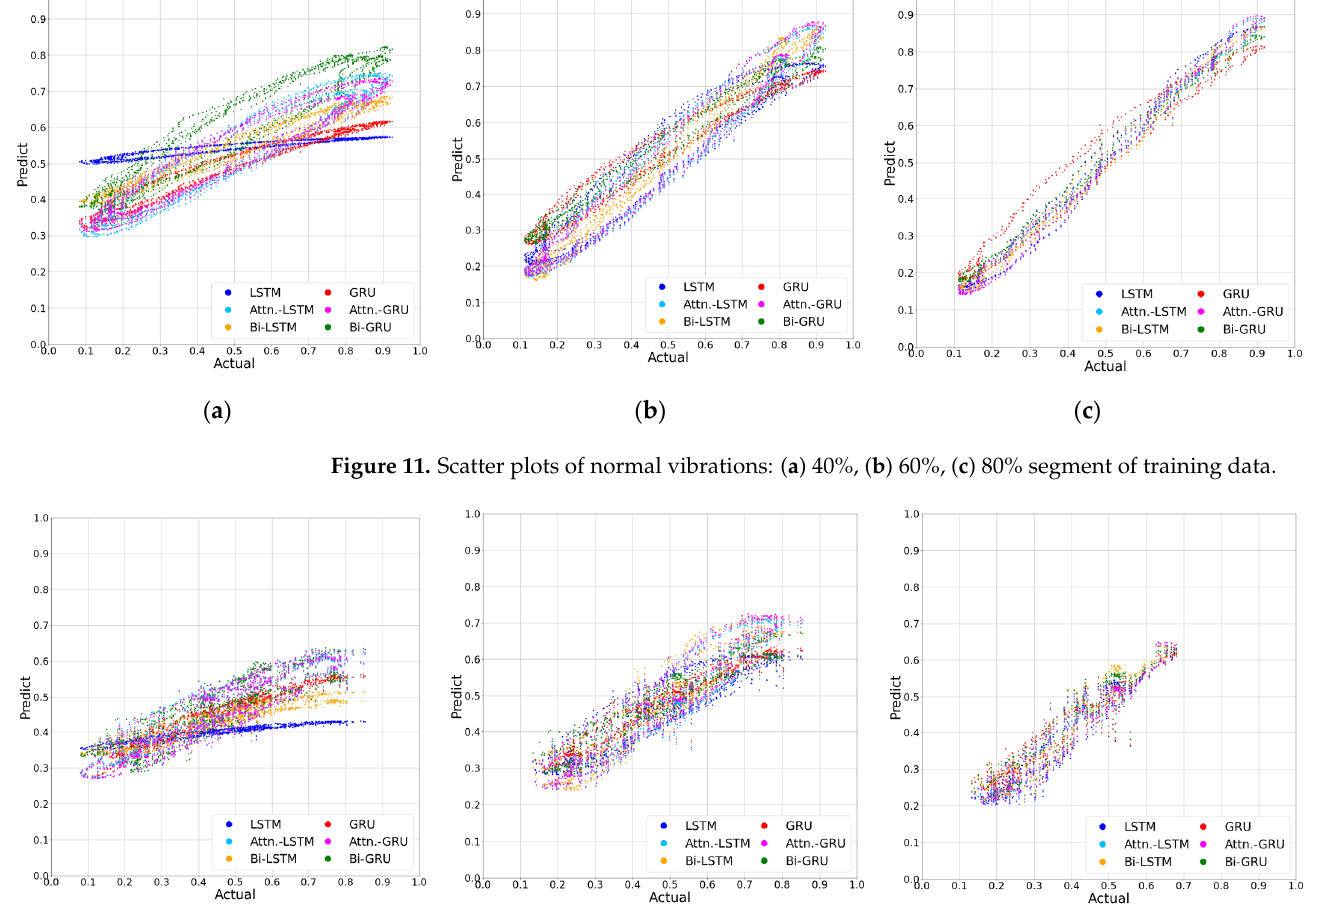
( c ) Figure 9. Waveforms of the vibrations predicted from the normal vibration: ( a ) 40%, ( b ) 60% ( c ) 80% segments of training data. ( a ) ( c ) Figure 10. Waveforms of the vibrations predicted from the abnormal vibrations: ( a ) 40%, ( b ) 60% ( c ) 80% segments of training data. In addition, according to the vibration prediction results in Figures 9a and 10a, the vibration prediction accuracy of LSTM was the lowest among the six RNN models when the size of the training dataset was 40%. As shown in Figures 9b and 10b, when the size of the training dataset was 60%, Attn.-LSTM and Attn.-GRU had the highest prediction accuracy, whereas LSTM and GRU exhibited the lowest prediction accuracy. Moreover,